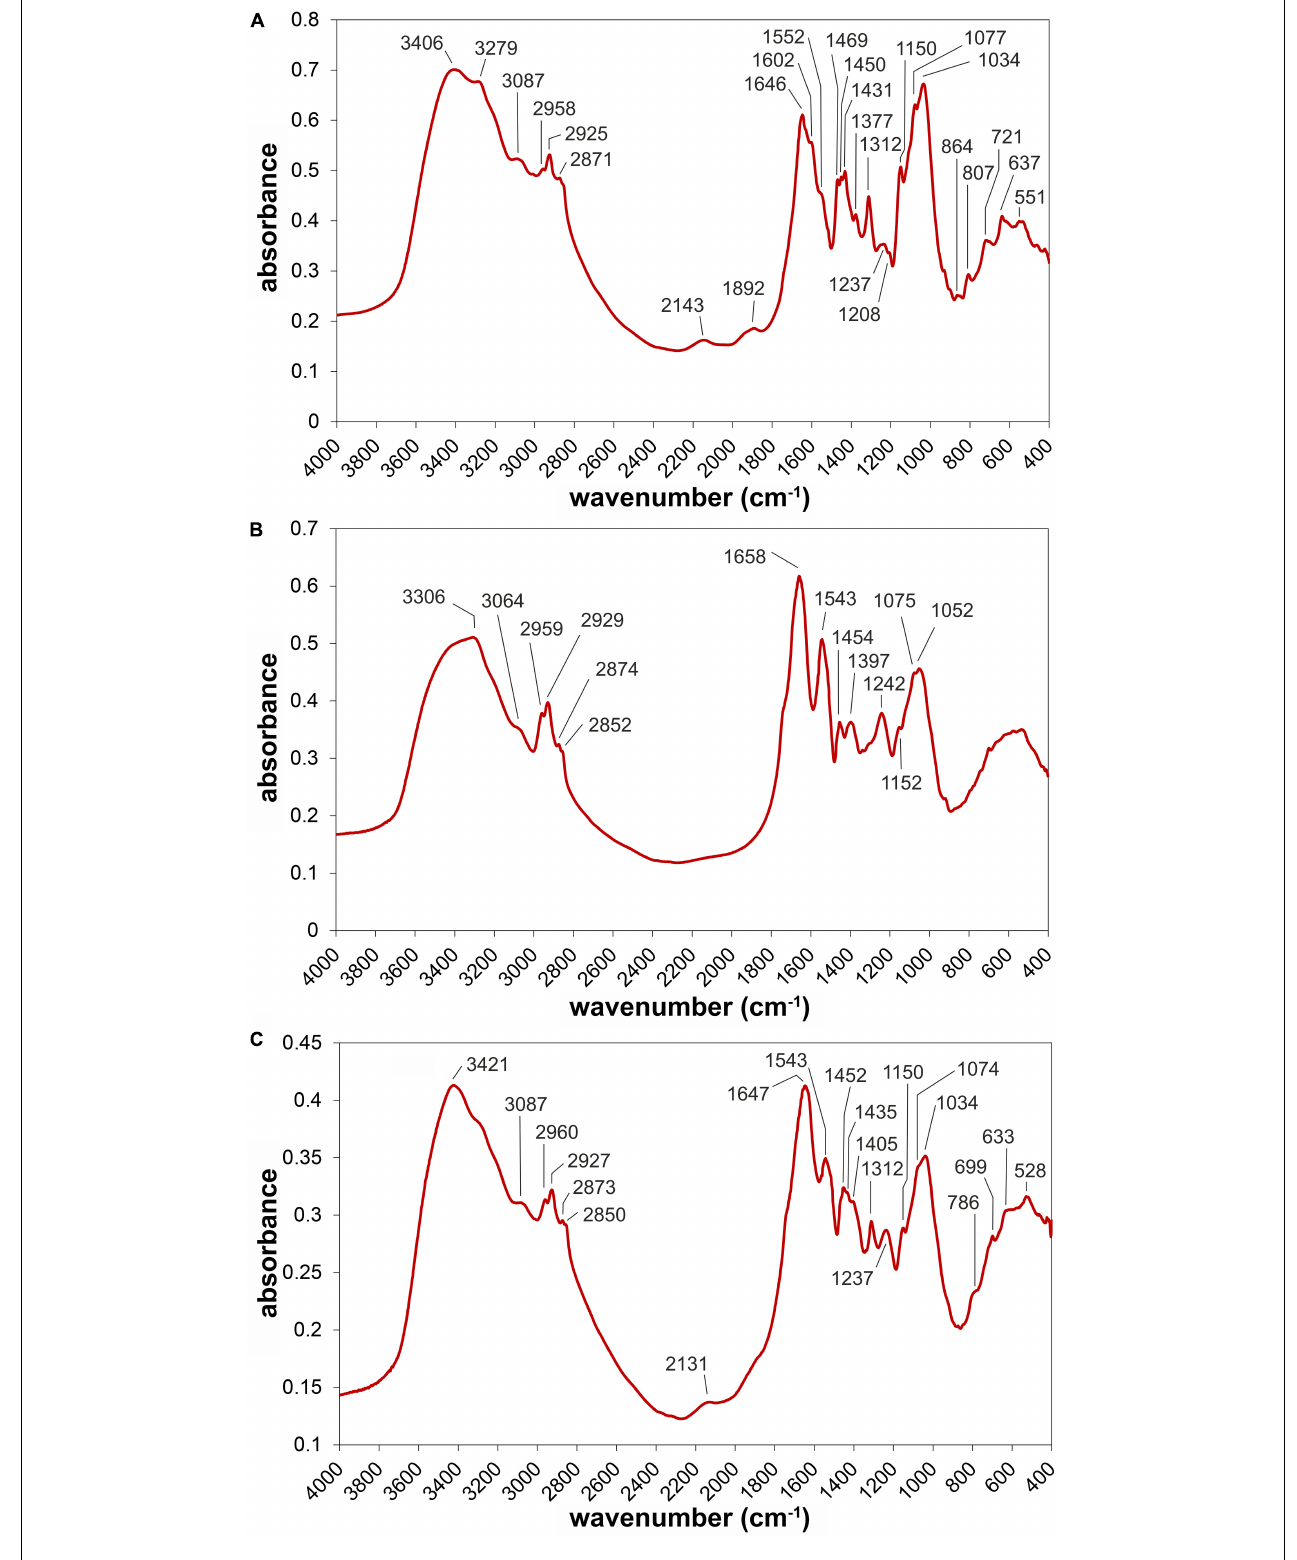
FIGURE 5 | FTIR spectra of Aspergillus niger biomass (A) , Chlorella sp. (B) , and the consortium of both microorganisms (C) , respectively.